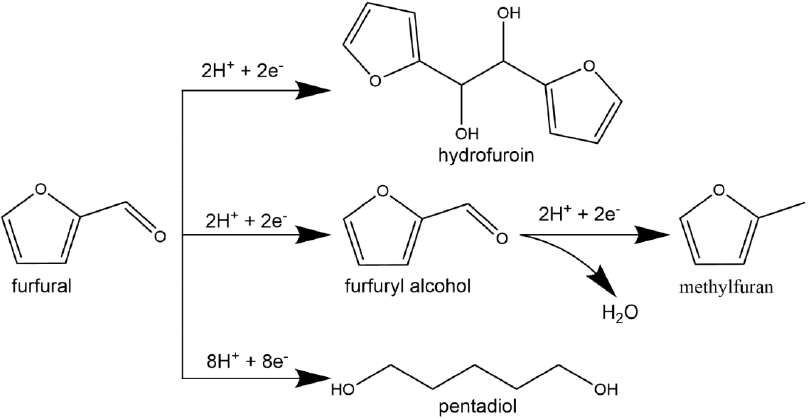
Figure 2. ECH reaction network of furfural hydrogenation. Adapted with permission from Refer- ence [42]. Copyright 2022 American Chemical Society.